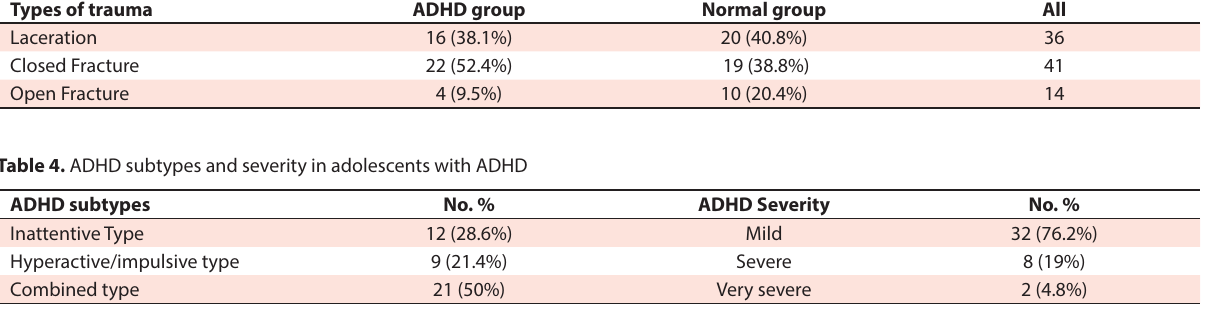
Table 3. Types of trauma frequency in different groups Types of trauma